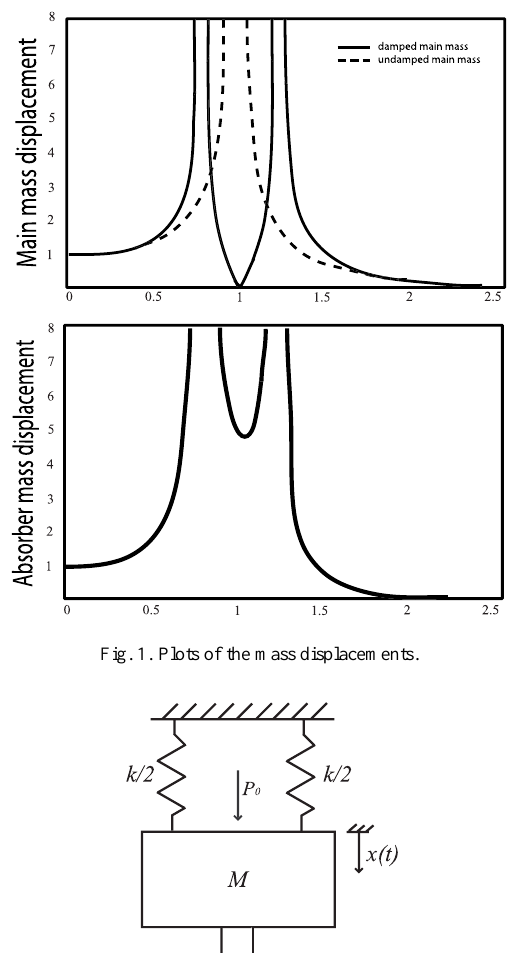
Fig. 2. Scheme of the dynamic vibrations